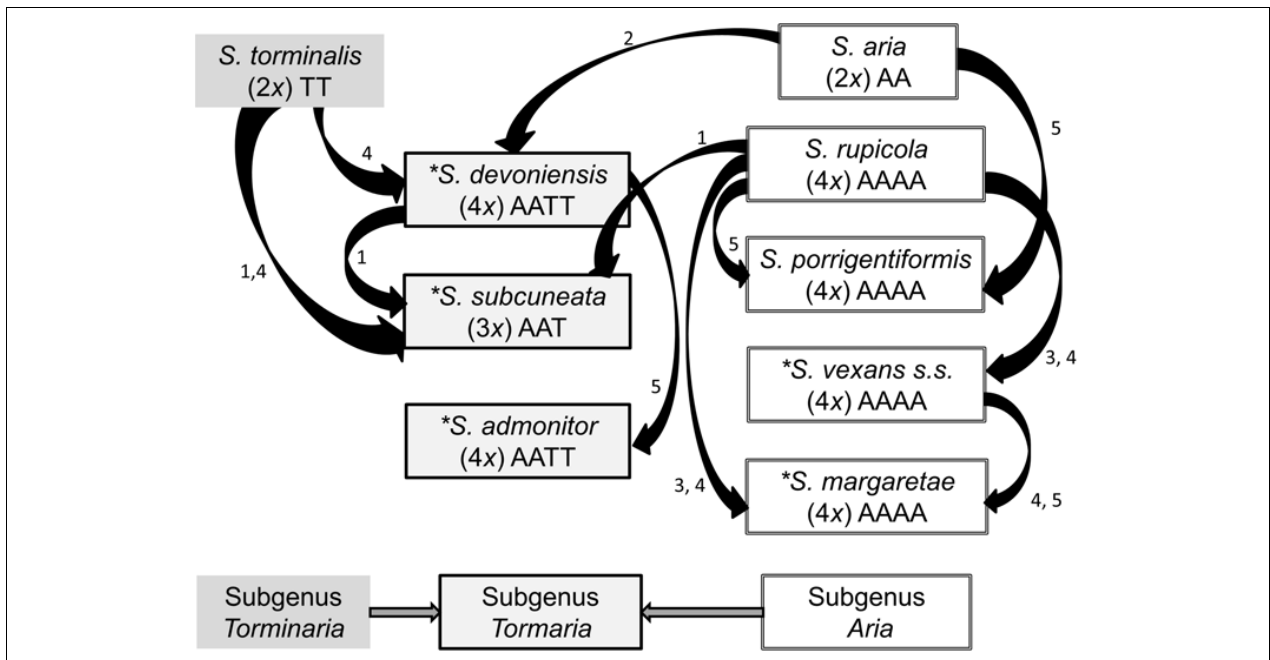
FIGURE 1 | Previously hypothesized relationships among the study Sorbus species based on the following literature. 1. Wilmott (1934), 2. Sell (1989), 3. Proctor et al. (1989), 4. Chester et al. (2007), 5. Rich et al. (2010). Haploid genomes from S. aria and S. torminalis are indicated by the letters A and T, respectively (Richards, 1975). The summarized relationships among the three subgenera are also shown; Sorbus torminalis is the ancestral maternal parent for subgenus Tormaria and polyploid members of subgenus Aria are derived from S. aria (Chester et al., 2007). Assumed ploidy is in parenthesis, from Pellicer et al. (2012). ∗ Taxa largely restricted to study region.